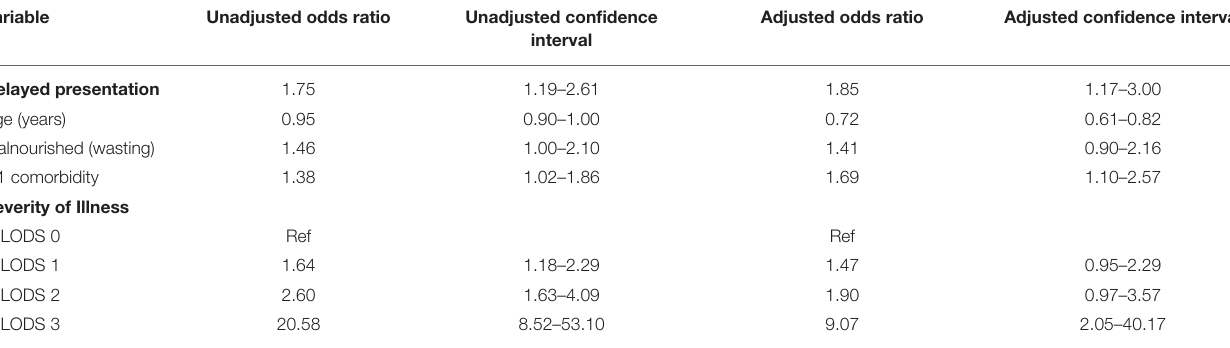
TABLE 5 | Adjusted and unadjusted odds ratios and 95% confidence intervals for delayed presentation given number of ownership variables as a measure of SES. Variable Unadjusted odds